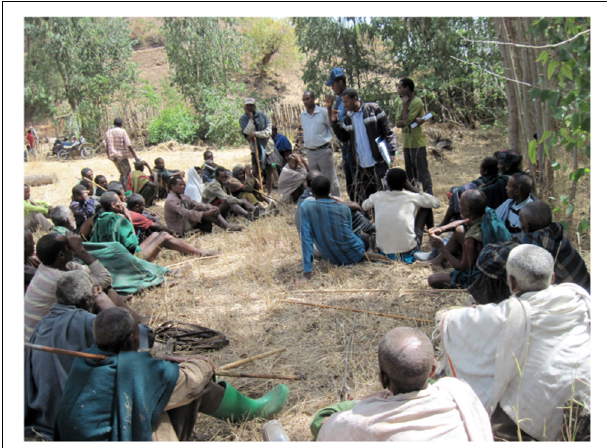
FIGURE 3 | Discussing ecosystem degradation resulting from farmers whose land surrounding the rehabilitated gully being unwilling to share the grass in the Tana Lake Region,